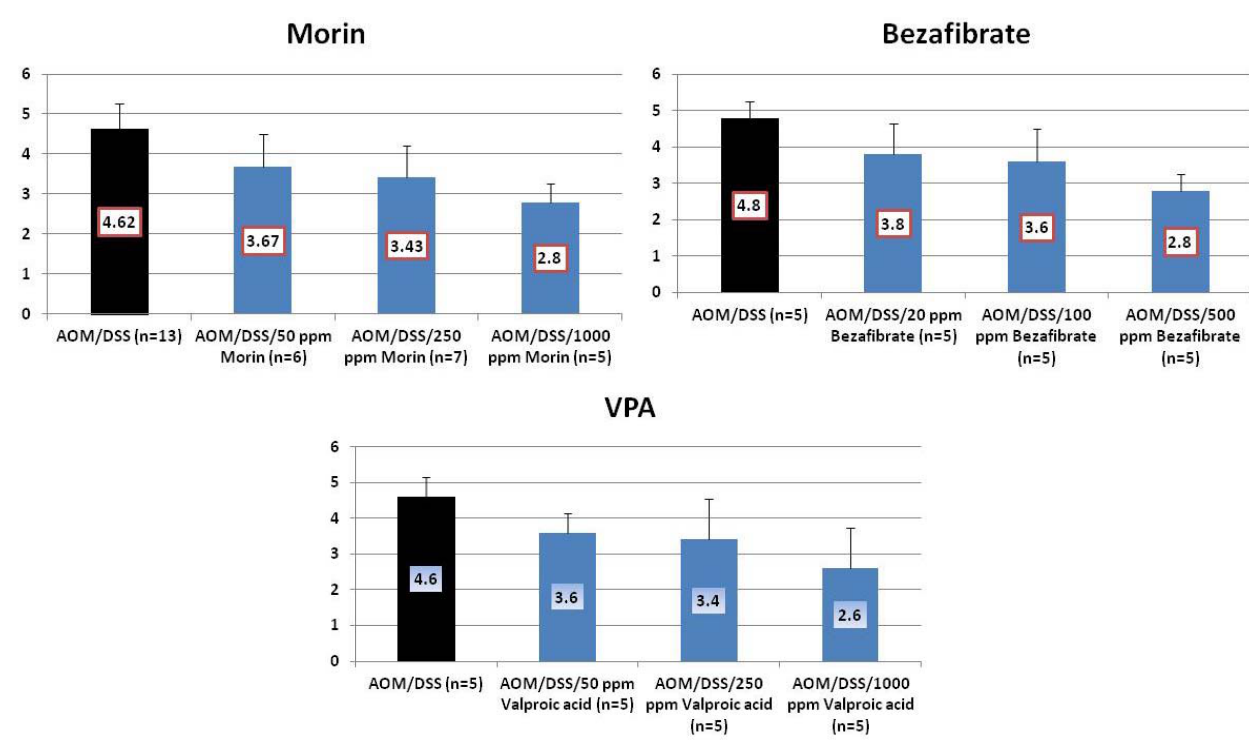
Figure 9. mRNA expression of NF- κ B in the colorectum of mice or rats from the morin, bezafibrate, and VPA studies.